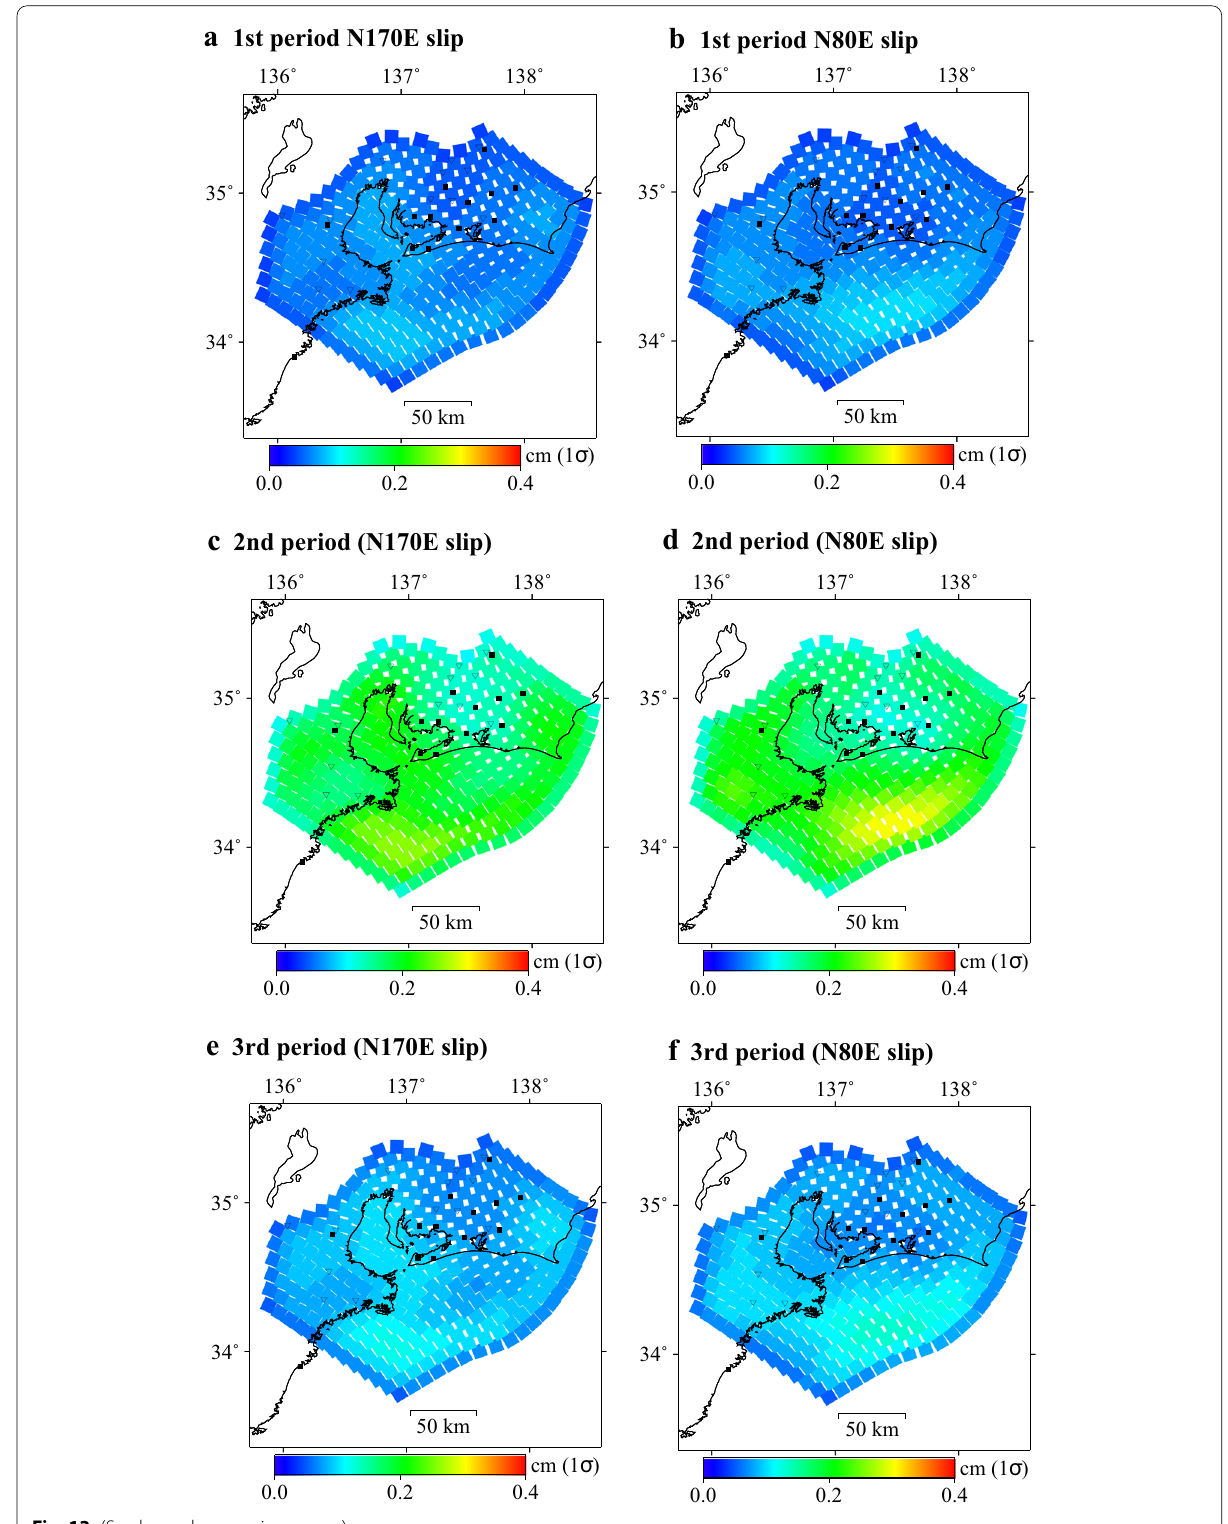
Fig. 13 (See legend on previous